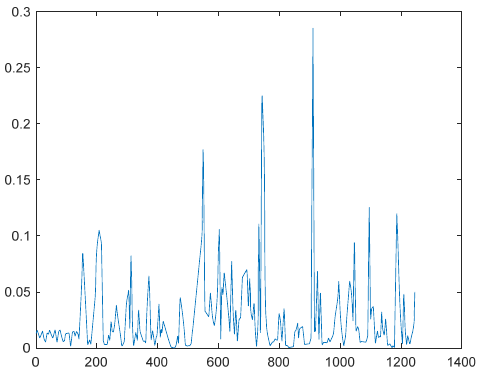
Figure 7 . Internally estimated positioning precision in 2D